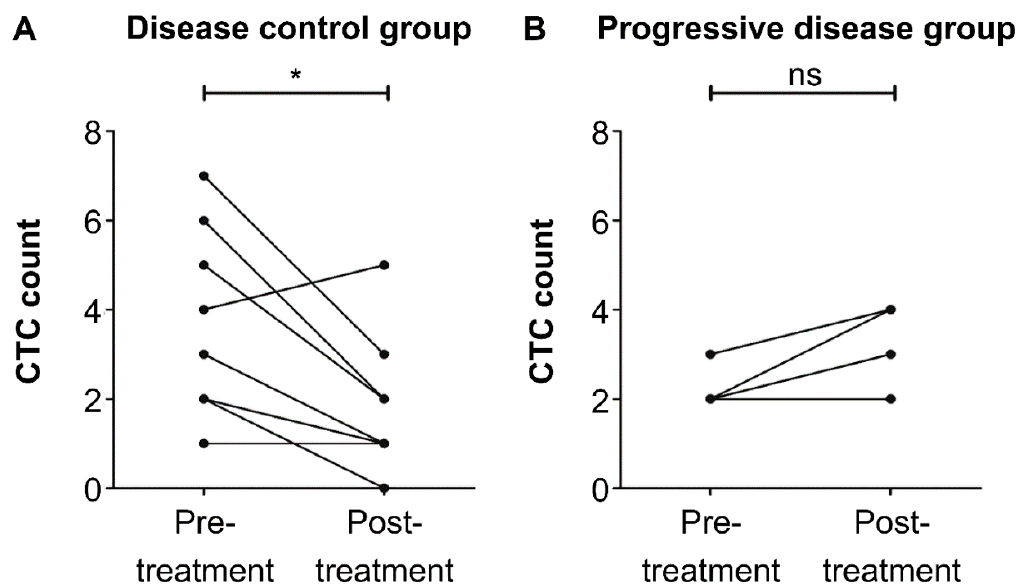
Figure 5. Time-course analysis of programmed cell death ligand 1 (PD-L1)-positive circulating tumor cell (CTC) count in patients with urothelial carcinoma (UC). The CTC levels were evaluated before and 3 months following the start of PD-L1 blockade therapy. ( A ) PD-L1-positive CTC in the disease control group of patients with PD-L1-positive CTCs (* p = 0.01). ( B ) PD-L1-positive CTC in the progressive disease group of patients with PD-L1-positive CTCs ( p = 0.25). ns: not significant.